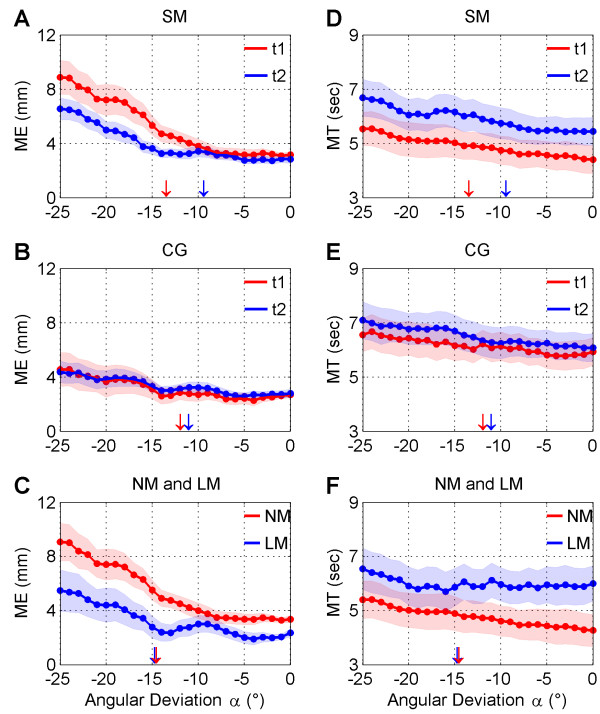
Mean and Standard Error of motor error (ME) and movement time (MT). ME and MT data are separately represented in the left panel and right panel respectively. A-D) Comparison of ME and MT values before and after the MBSR intervention. B-E) Comparison of ME and MT average at times t1 and t2 in the CG group. C-F) ME and MT are represented for the comparison of the LM and NM groups respectively. Shading indicates standard error (SE). Data for t1 and t2 measurement points and groups LM and NM are denoted by blue and red colors respectively. Downward arrows indicate the adjusted mean of angular threshold in each group and measurement point (same color coding).